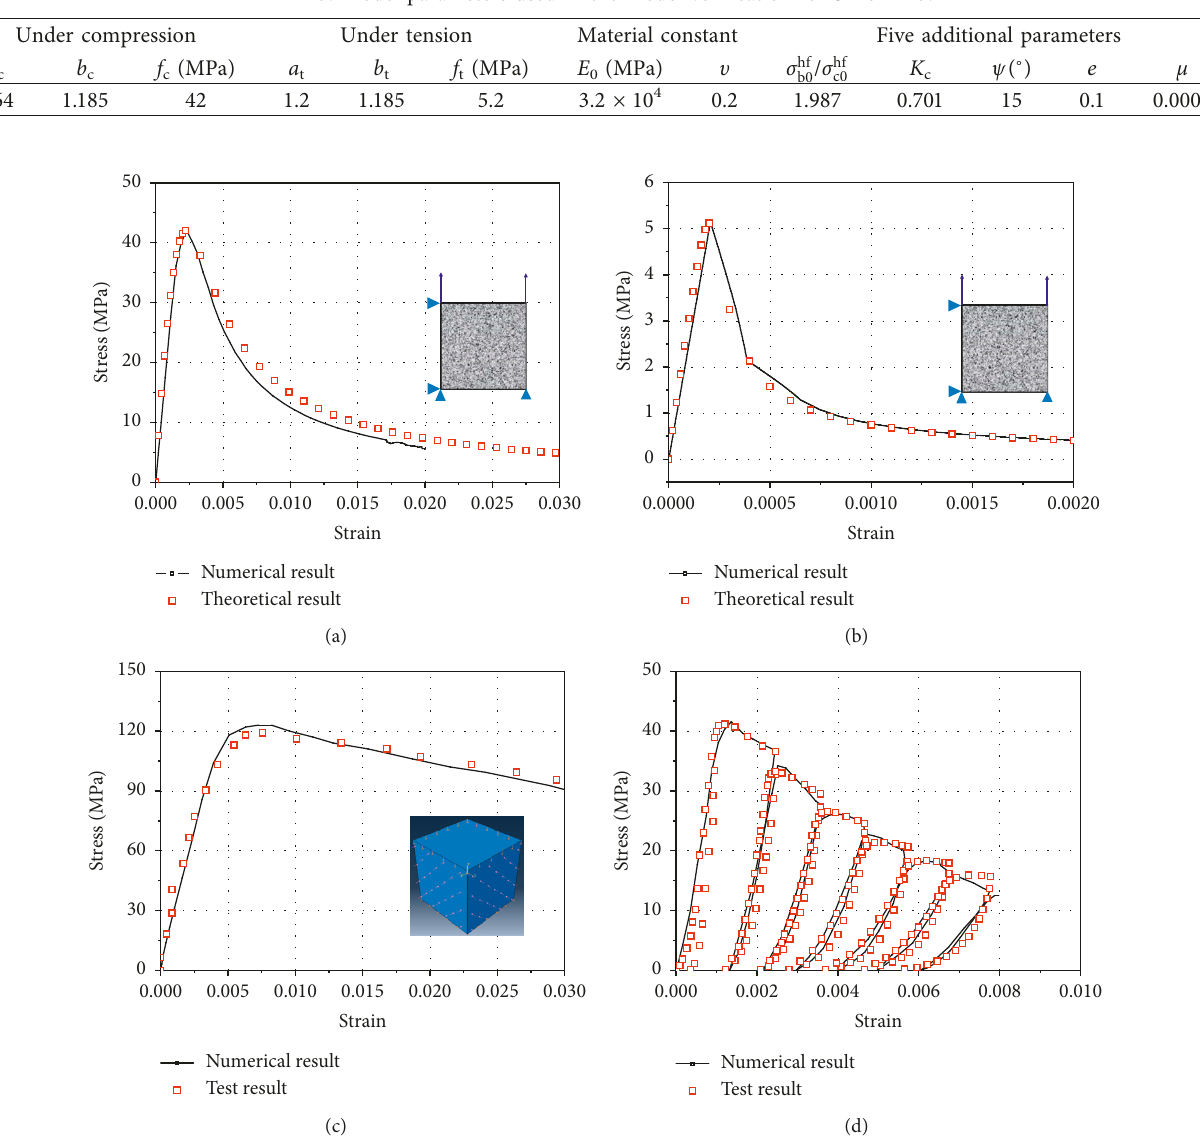
Table 5: Model parameters used in the model verification for SB15PA15.